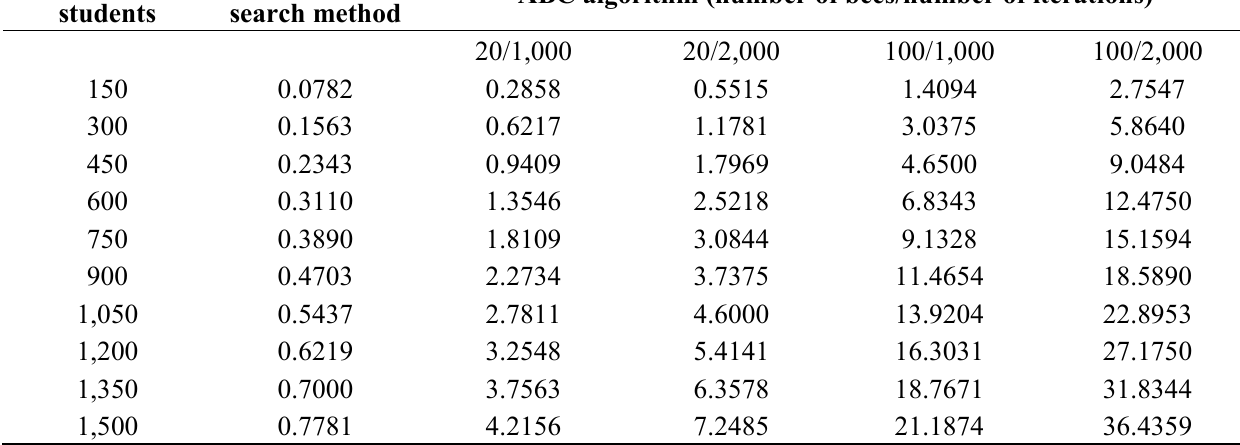
Table 3. Comparison of average execution time values for the random search method and the ABC